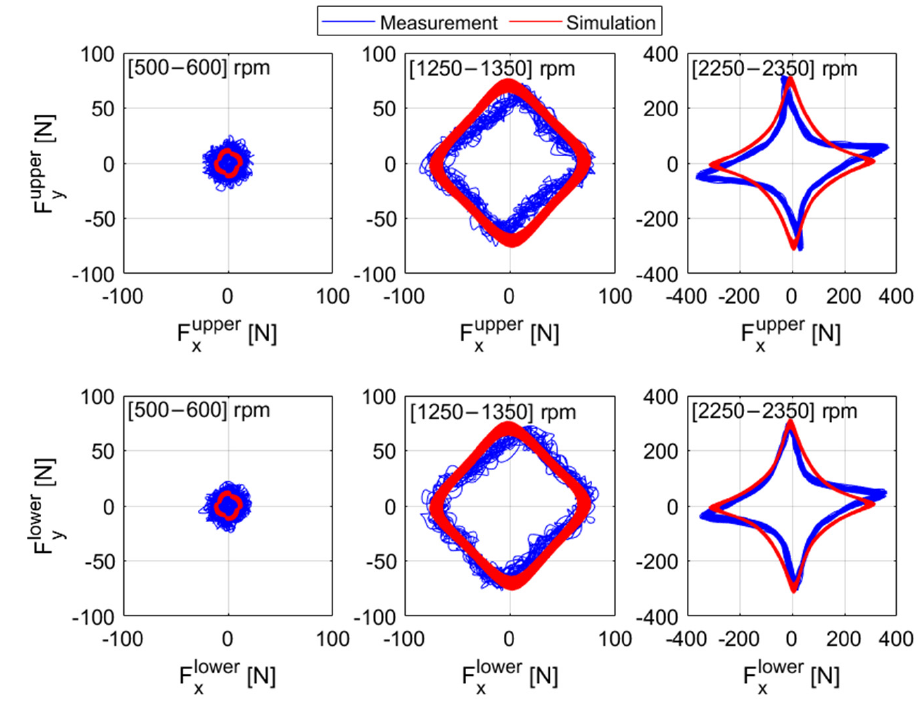
Figure 19. The simulated and measured orbit of the shaft with 5.9 × 10 − 3 kg·m unbalance magnitude and 2 π rad/s 2 angular acceleration.